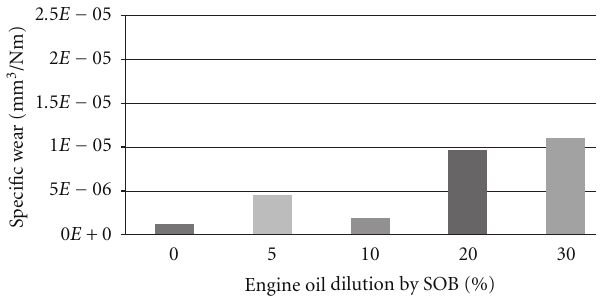
Figure 8: Specific wear for chicken-fat biodiesel (CFB) diluted engine oil mixtures.